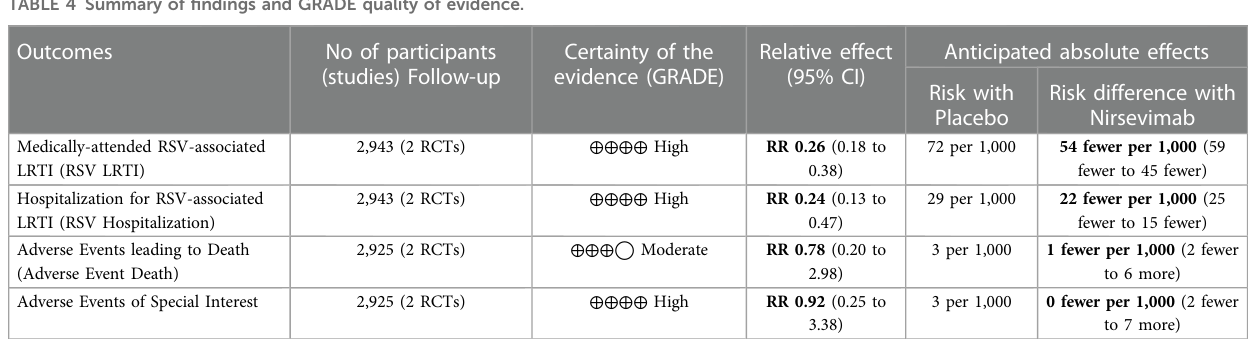
TABLE 4 Summary of fi ndings and GRADE quality of evidence.